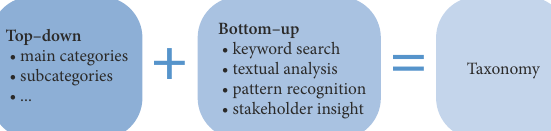
Figure 5. Taxonomy building hybrid process